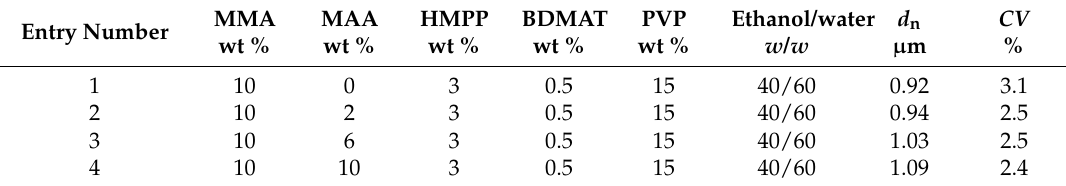
* All polymerizations were conducted at room temperature for 3